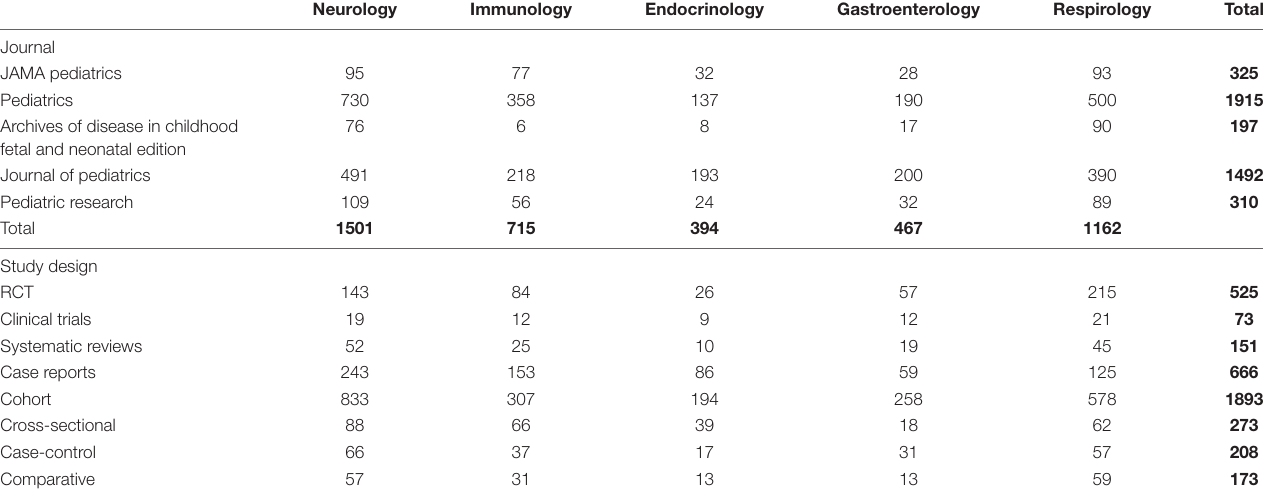
TABLE 2 | Distribution of publications in pediatric journals in each of the 5 specialties by journal and by study design.